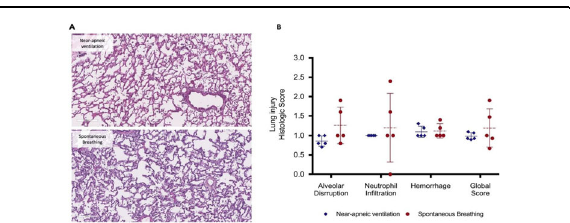
Fig. 1 (abstract 001085). Histological assesment of lung injury.( A ) Representative images of lung histology for each group (original magnification: 10x hematoxilin and eosin). Images of both, near- apneic ventatilation and spontaneous ventilation groups shown similar diffuse alveolar; ( B ) Quantative score for lung injury (from 0 = normal, to 3 = maximal alteration), calculated by averaging the scores for alveolar disruption, neutrophil infiltration, and hemorrhage of the right lung, and the global score (mean of scores).